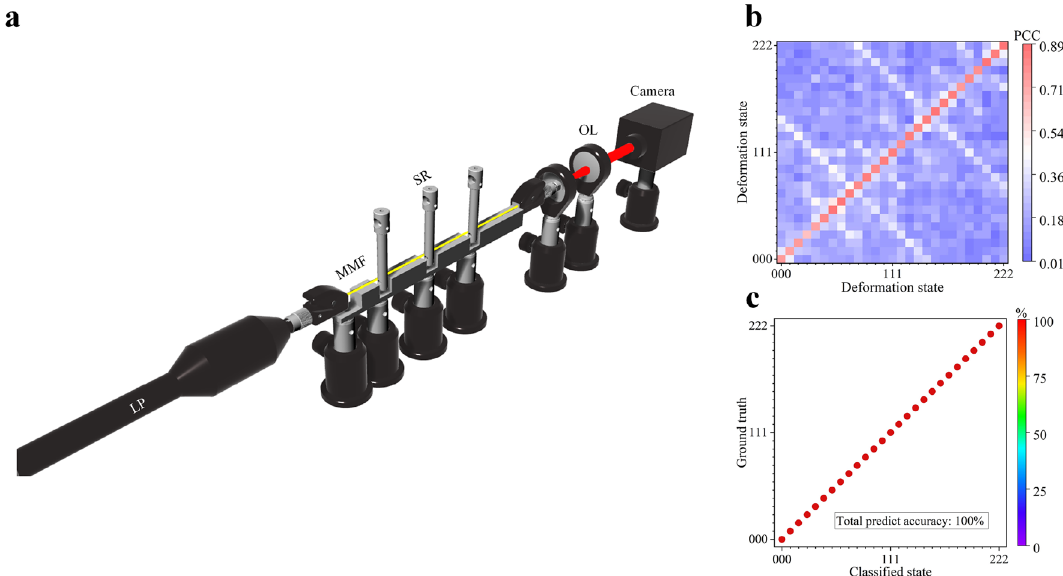
Figure 3. ( a ) Experimental setup for 2D multi-point deformation classification. ( b ) Average PCC between the speckle collected in the first measurements and speckles collected in the rest measurements. ( c ) Normalized confusion matrices for the KNN classification. The deformation states are defined by a deformation coordinates ( Y